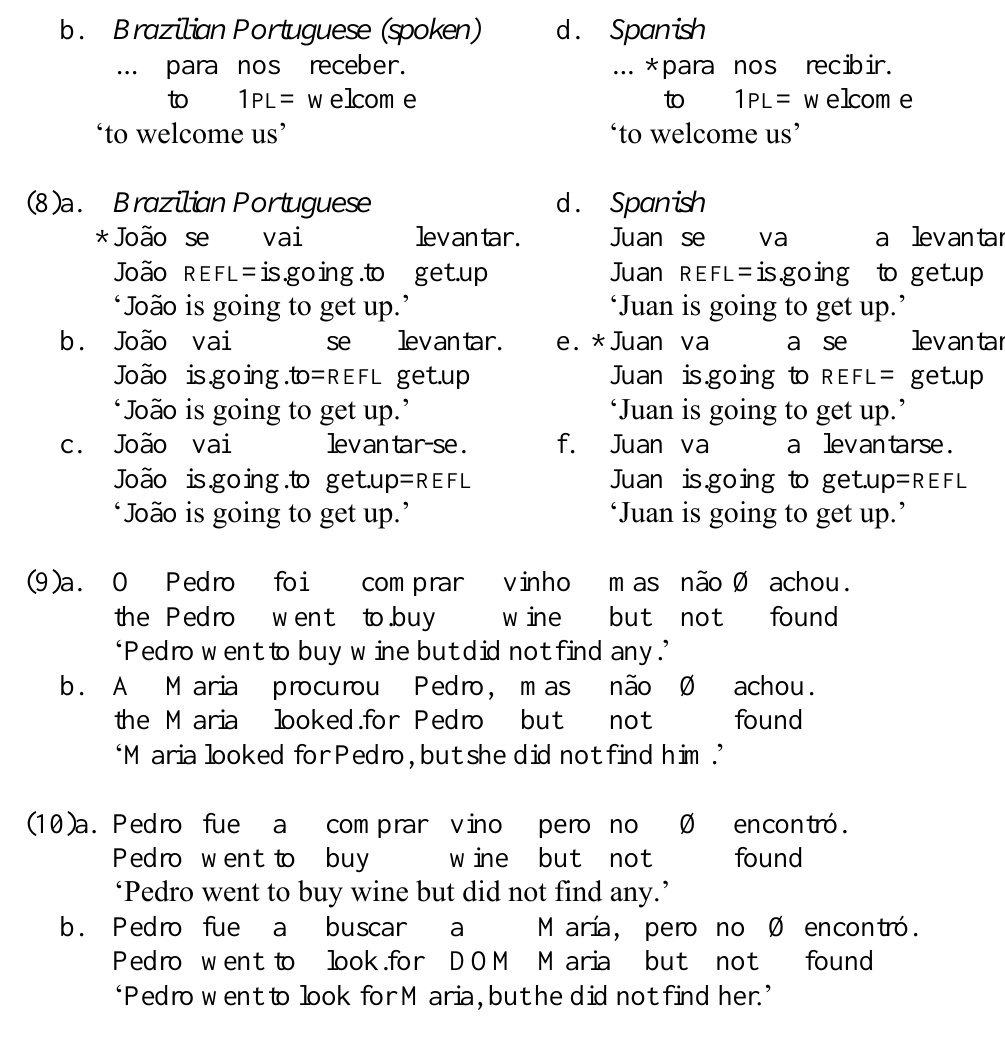
Table 1 . Cross-linguistic differences in object expression between Brazilian Portuguese, Spanish and